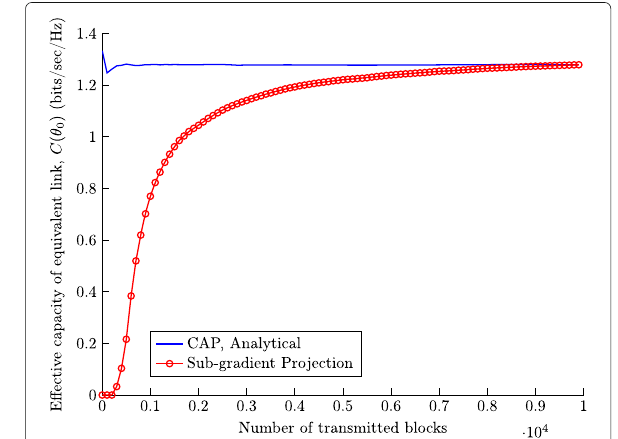
Fig. 6 Effective capacity versus number of transmitted blocks; analytical approach compared with the sub-gradient projection and Nakagami-m fading channels with m i = 3, 0 ≤ i ≤